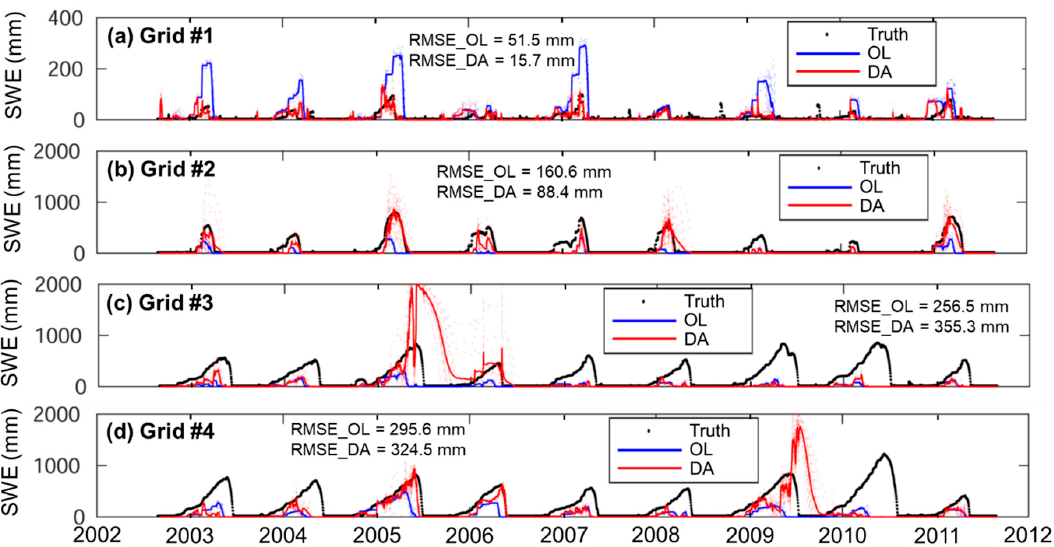
Figure 3. Time series of snow water equivalent (SWE) from the synthetic truth (black dots), open loop (OL; blue lines), and data assimilation (DA; red lines) for the four different experimental locations: ( a ) Grid #1, ( b ) Grid #2, ( c ) Grid #3, and ( d ) Grid #4 (see Table 3 for geographical characteristics of the grid cells). The solid and dotted lines denote the ensemble mean and range of the simulated SWE, respectively.